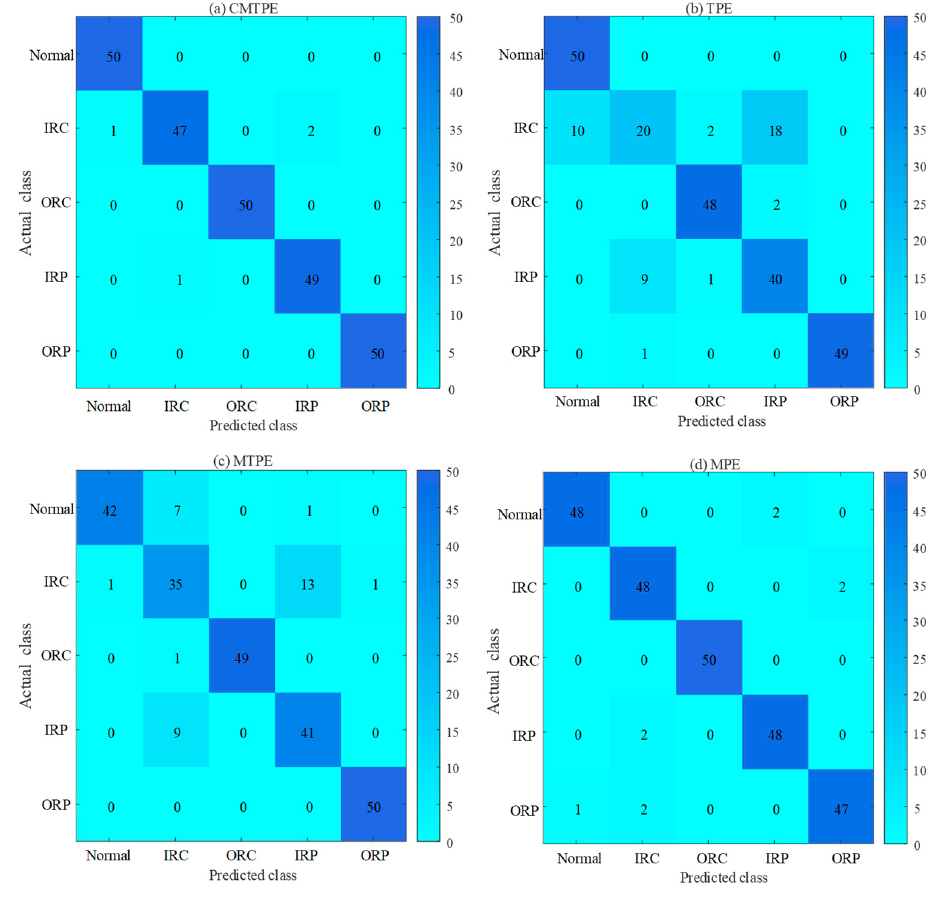
Figure 10. Confusion matrix of four methods.